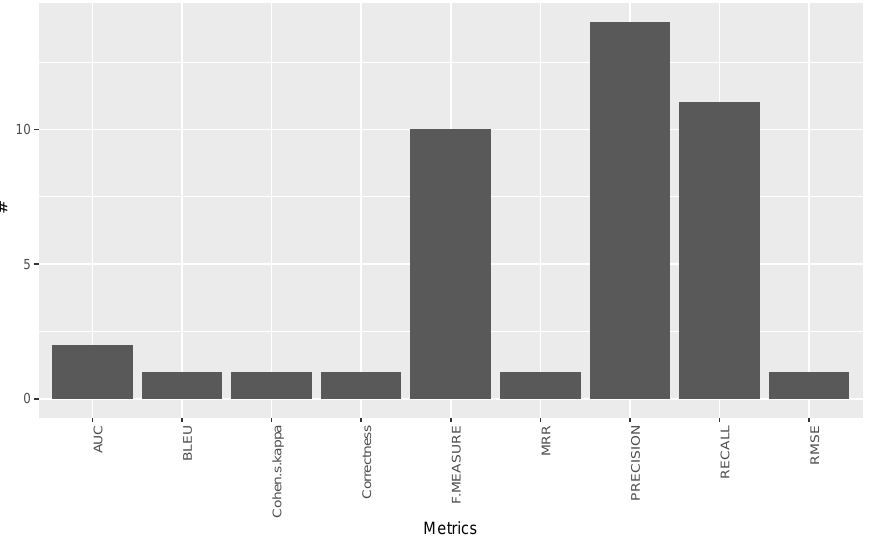
Figure 14. Evaluation metrics. (Authors’